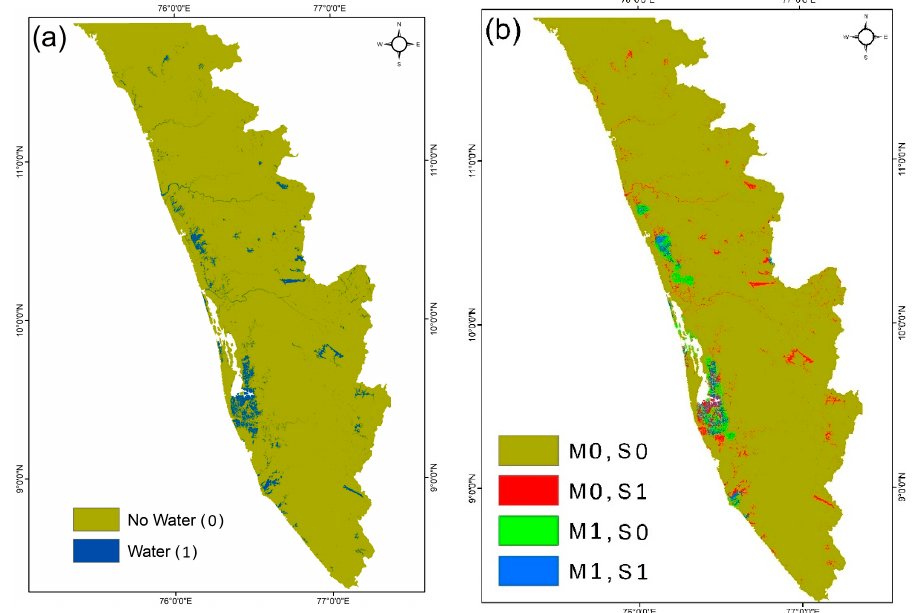
Figure 5. ( a ) Flood inundation derived from Sentinel-1 synthetic aperture radar (SAR) imagery; ( b ) model (M) output for threshold 15 and Sentinel (S) flood inundation maps (water—1, and no water—0) overlaid on each other over Kerala on 23 August 2018.